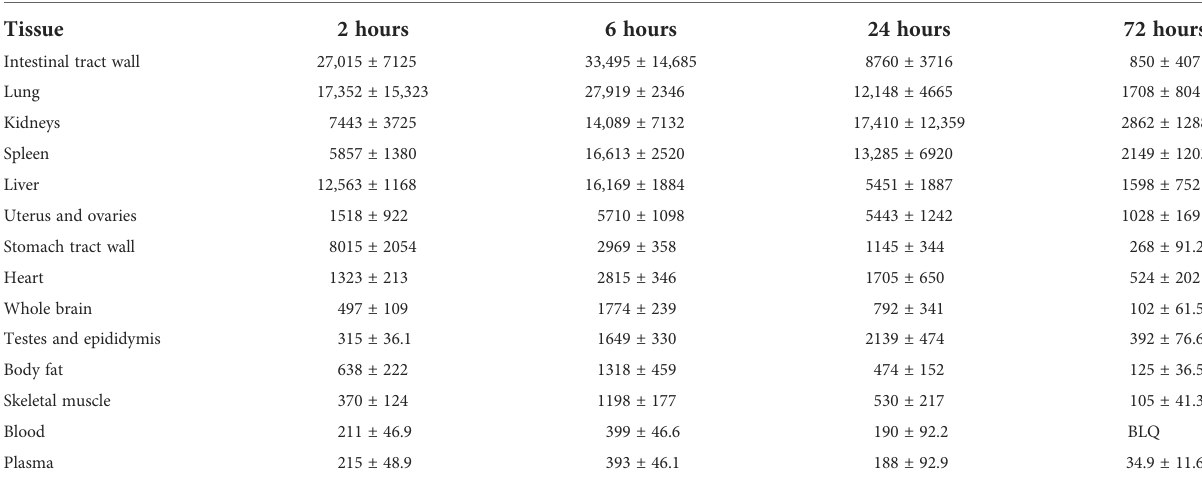
Total detected radioactivity (ng eq/g)